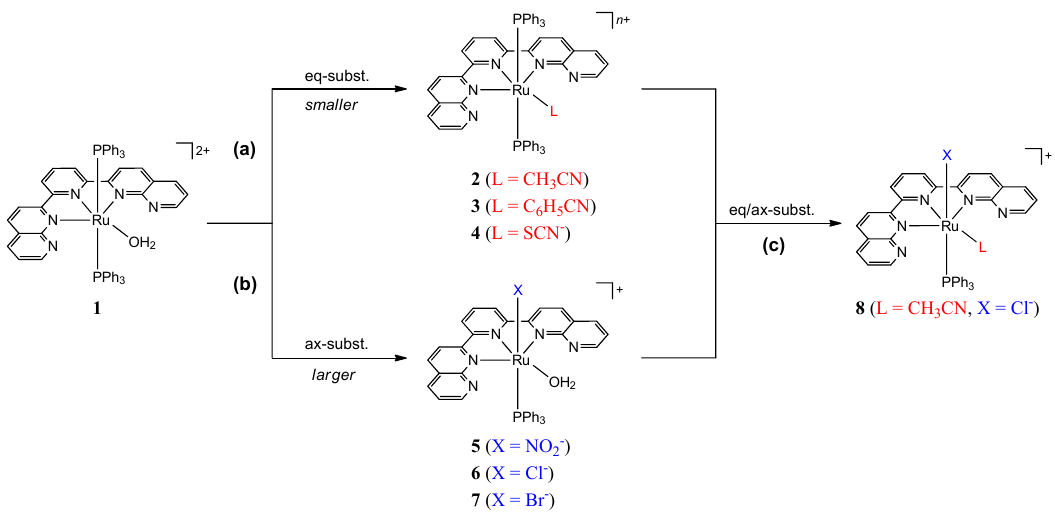
Figure 1. Synthetic routes for complexes 2 – 8 . Eq-subst. and ax-subst. denote equatorial position substitution and axial position substitution,